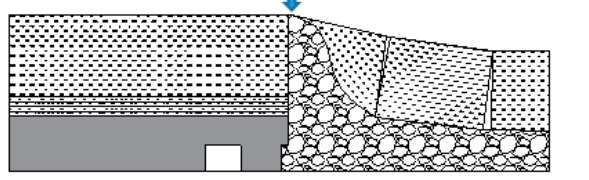
Figure 12. Pressure relief technology for non-penetrating directional presplitting blasting with a deep hole ahead.